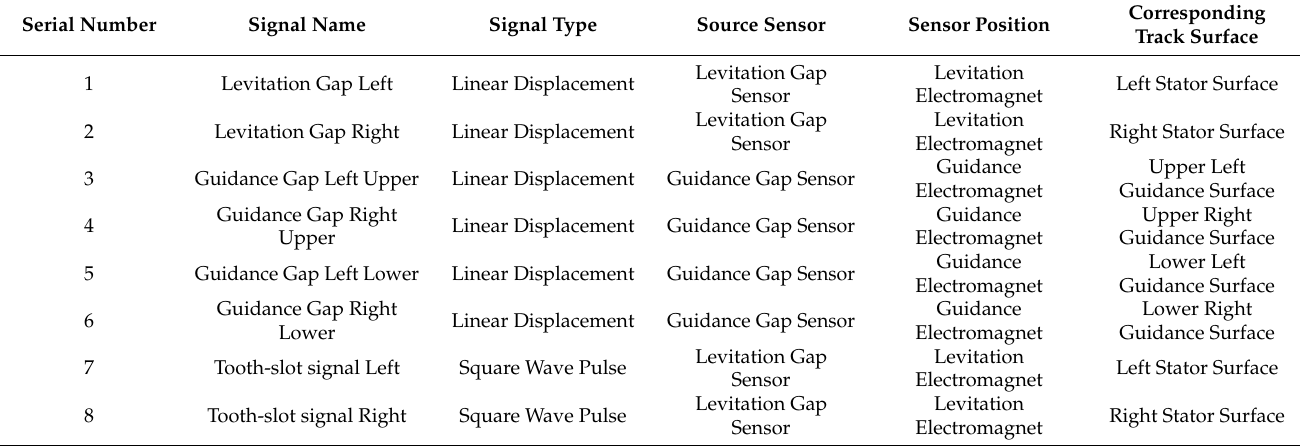
Table 1. Summary of sensor